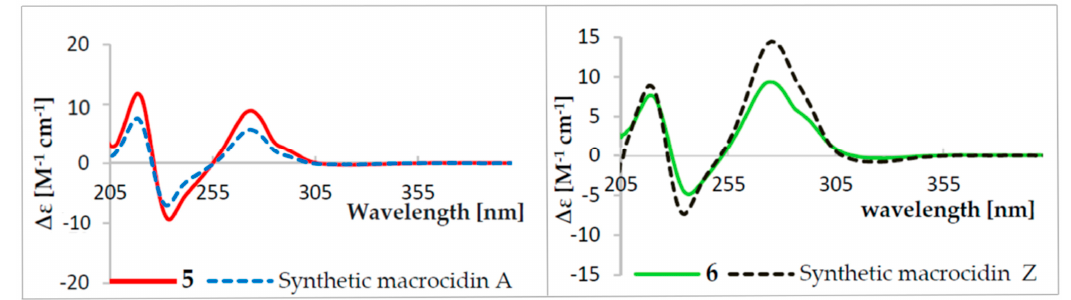
Figure 3. ECD spectra of isolated and synthetic macrocidins A ( 5 ) and Z ( 6 ) in